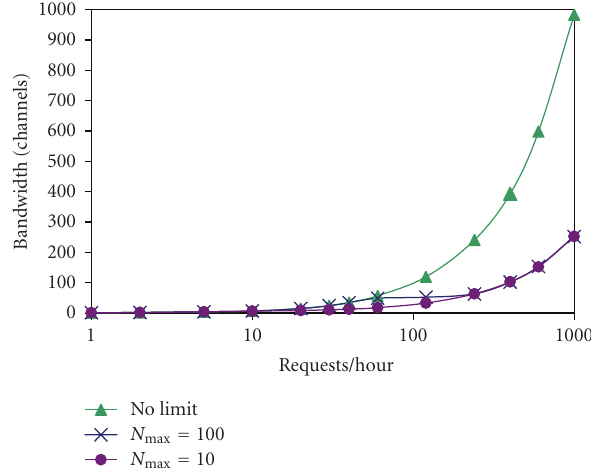
Figure 7: Network bandwidth requirements of the protocol for α = 0.25, and β max =